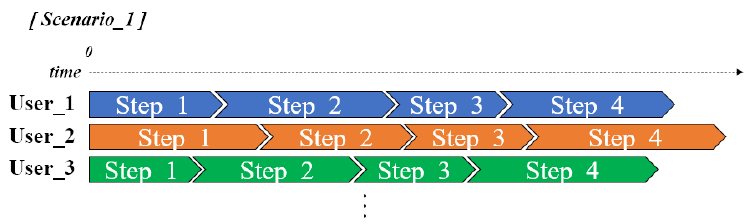
Figure 4. The time limit table required for each user to perform each step in the scenario.